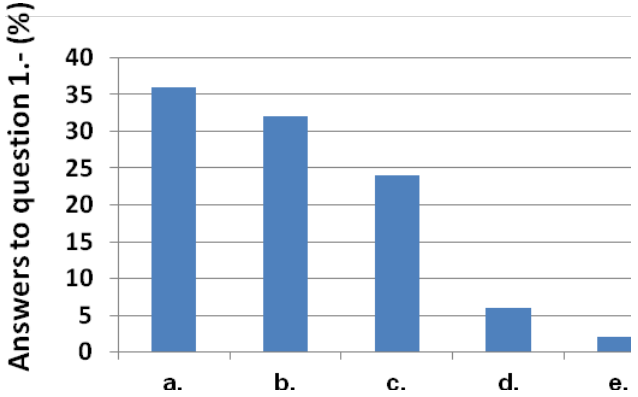
Fig.3. Distribution of answers to question